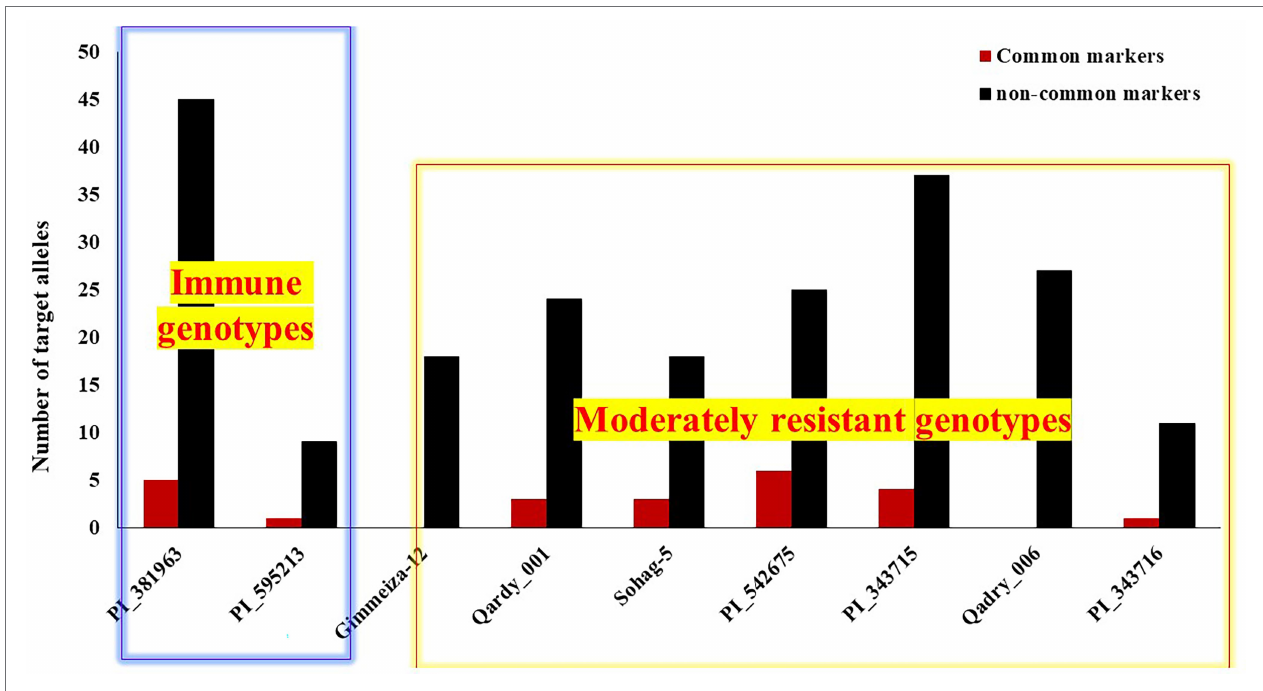
FIGURE 8 | Number of targeted alleles of the significant markers in the two immune and the seven moderately resistant